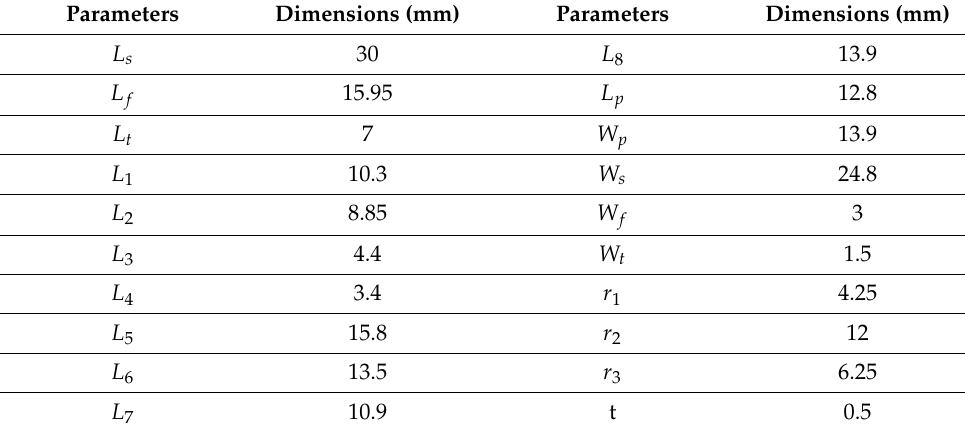
Table 1. The proposed antenna’s optimized